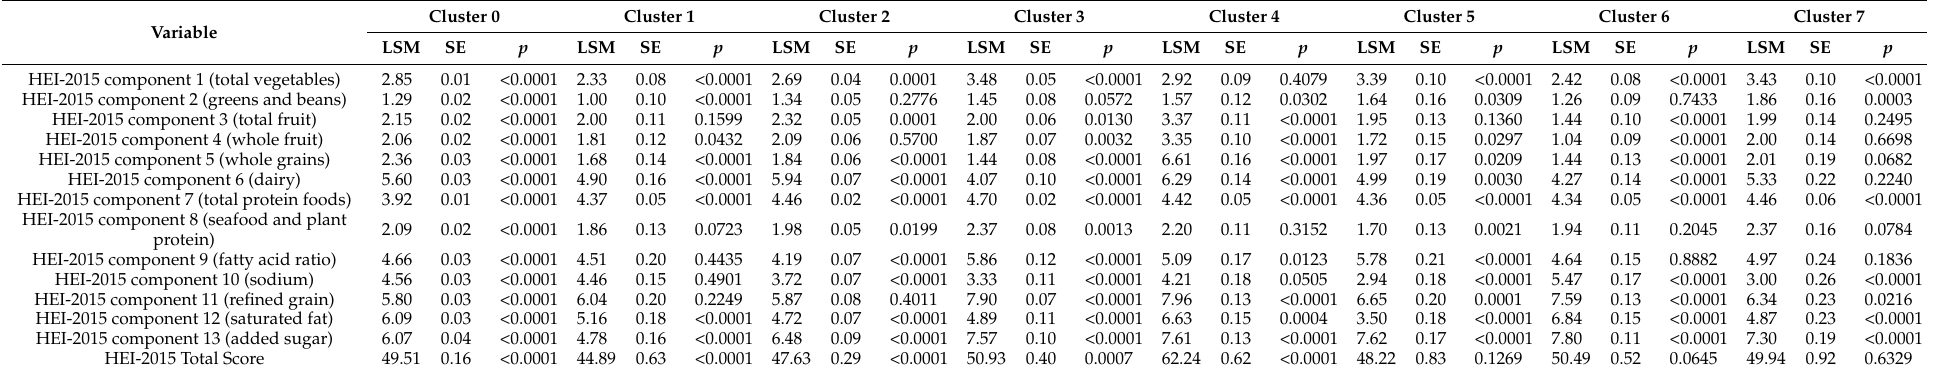
Table 4. Least square mean total and subcomponent Healthy Eating Index (2015) scores by egg cluster in